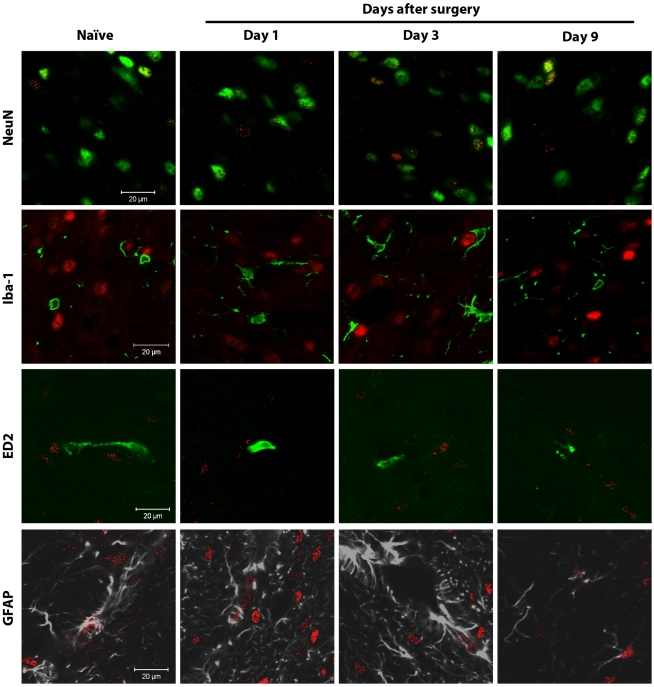
Spinal CB1 receptors are mainly expressed in neurons.Confocal analysis was used to determine spinal CB1 receptor cellular localization in the superficial laminae of the L5 dorsal horn in naïve rats or ipsilateral to surgery in rats at days 1, 3 and 9 after paw incision. Representative images are shown. CB1 receptor staining appears in red. NeuN (marker for neurons), Iba-1 (marker for microglia) and ED2/CD163 (ED2, marker for perivascular microglia) appear in green. GFAP (marker for astrocytes) appears in grey. In the images of CB1 receptors and Iba-1, CB1 receptor staining originally appeared green, and Iba-1 appeared in red. These colors were digitally switched in order to consistently represent CB1 receptor staining in red in all images. In the images of CB1 receptors and GFAP, GFAP staining originally appeared in green. The color of GFAP staining was digitally changed to grey in order to allow better visualization of occasional staining of CB1 receptors on GFAP-positive cells. The colocalization of CB1 receptors and NeuN staining appears in yellow.